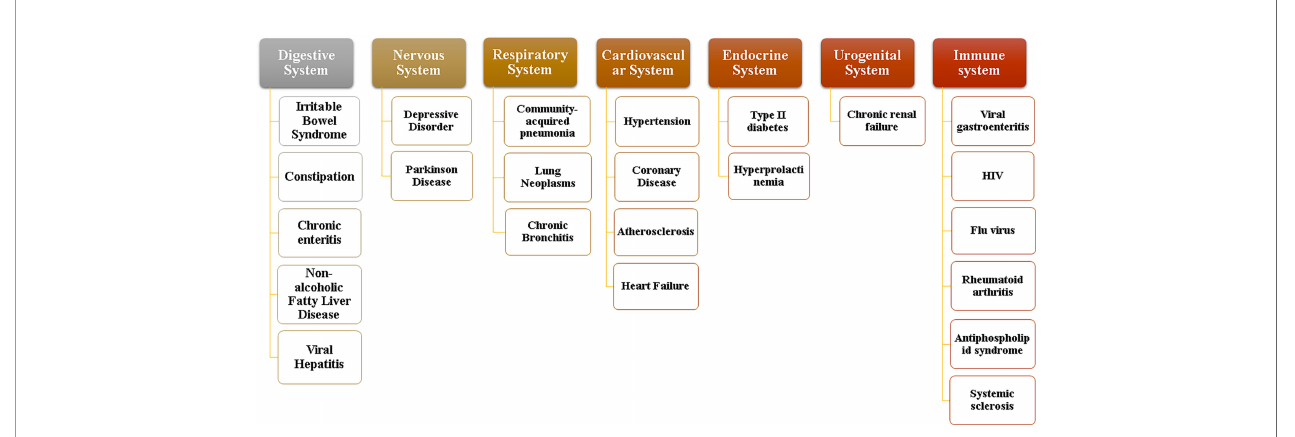
FIGURE 2 | System diseases involving intestinal